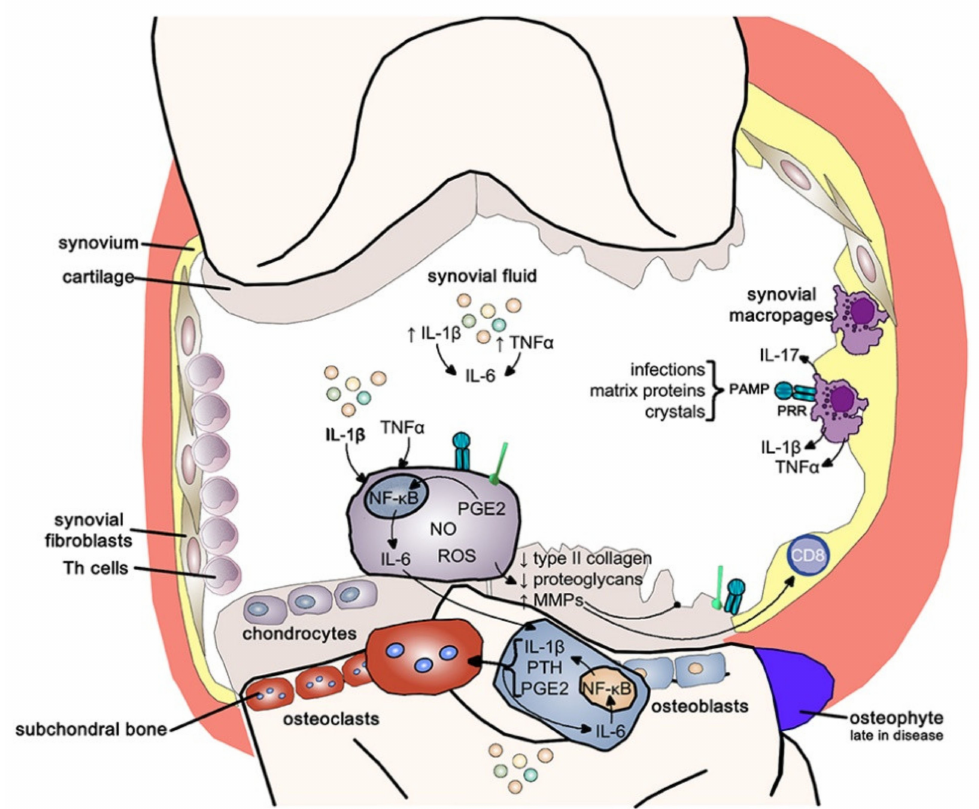
Figure 1. Structures of normal (left part of the figure) and osteoarthritic (right part) cartilages, as well as inflammation pathways in OA. Reprinted with permission from Bennett et al, Front. Med., published by Frontiers Media,